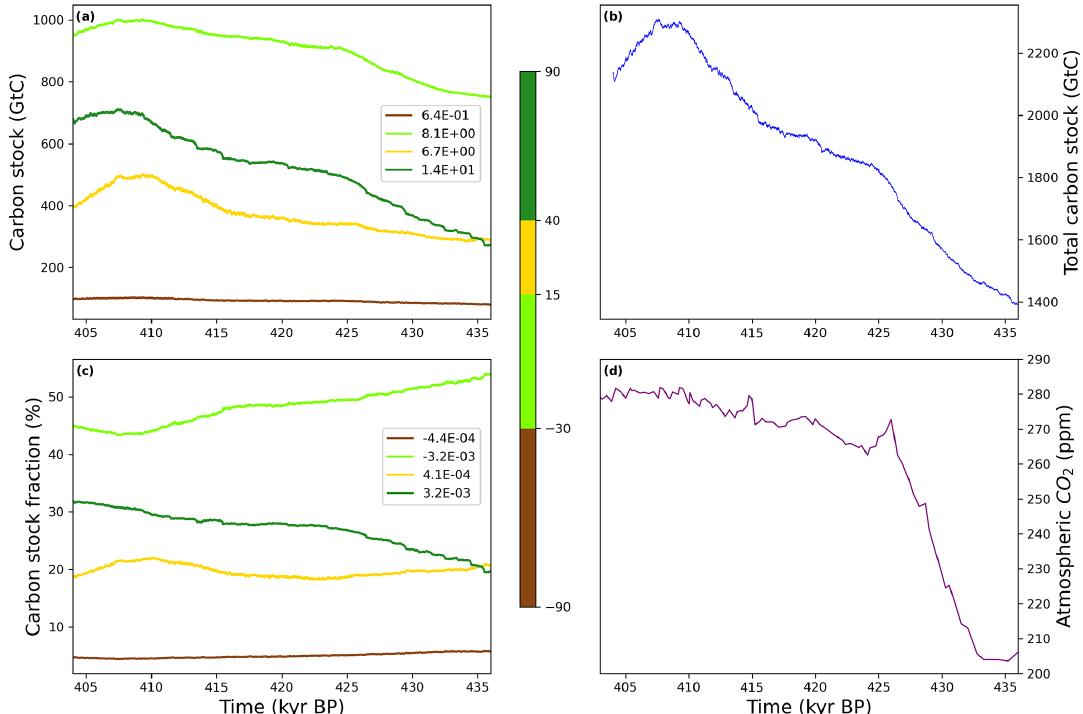
Figure 9. Zonal averages of simulated terrestrial biosphere (a) carbon stock (GtC) and (c) fraction of total carbon stocks (%) across TV. Panel (b) features the total carbon stock of the simulated terrestrial biosphere and (d) the atmospheric CO 2 concentration from Nehrbass-Ahles et al. (2020). The simulated carbon stock is derived from the net productivity computed over each continental grid (Brovkin et al., 2002; see Sect. 2.3.1). The linear regression coefficient (GtCkyr − 1 ) is provided for each zonally averaged time series ( a and b ). Panel (c) presents the total simulated terrestrial biosphere carbon stock (GtC) across